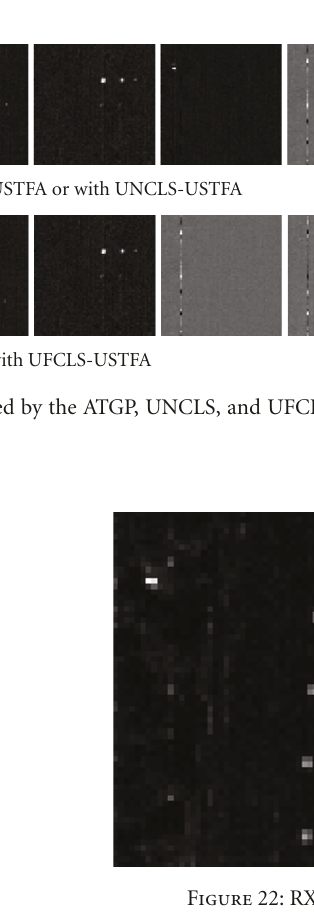
Figure 20: 9 endmembers extracted by N-FINDR.